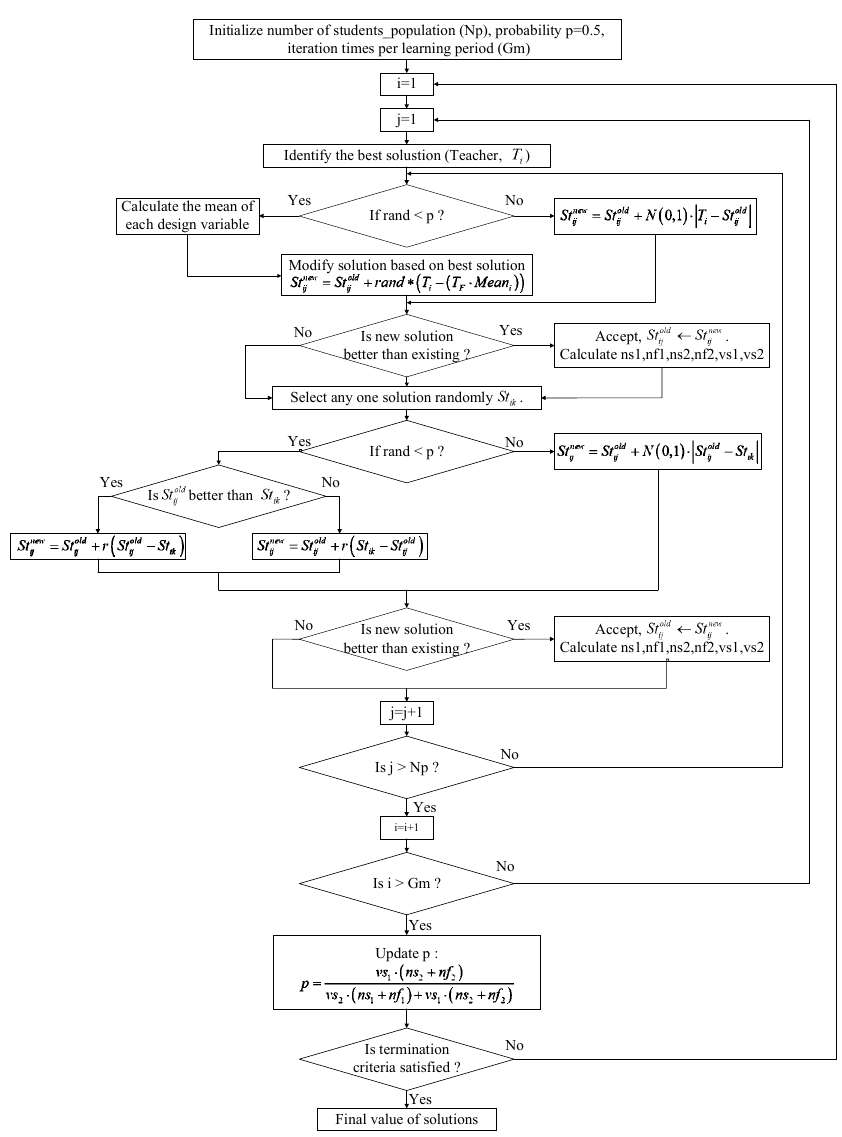
Figure 8. The flow chart of the self-adaptive hybrid TLBO.